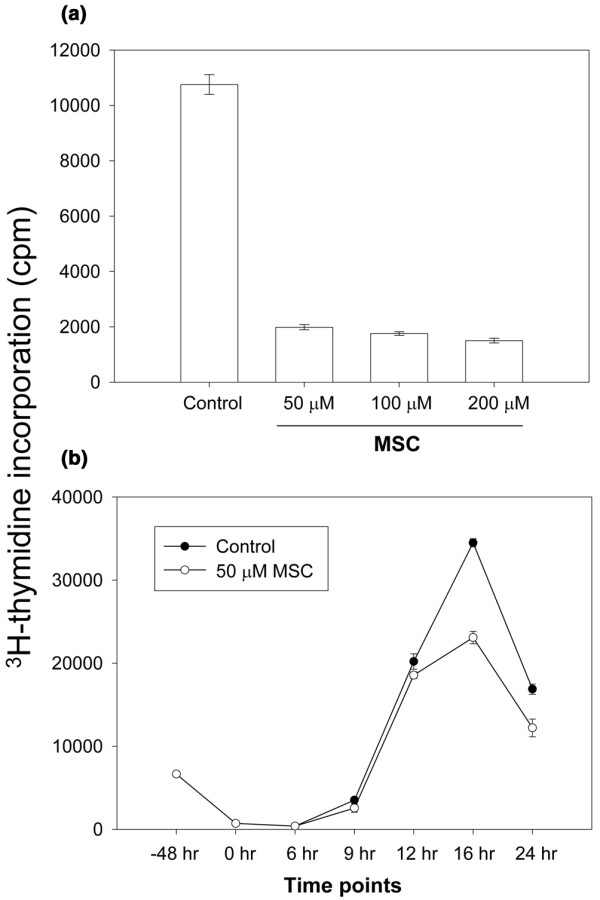
[3H]Thymidine incorporation into TM6 cells after Se-methylselenocysteine (MSC) treatment. (a) Asynchronous TM6 cells were grown for 24 hours and treated with various concentrations of MSC for 48 hours to determine the optimum dose for treating synchronized cells. (b) Synchronized TM6 cells were treated with 50 μM MSC at 6 hours and the DNA synthesis was measured by [3H]thymidine incorporation at the indicated time points as described in the Materials and methods section. Data are presented as means ± SEM for three observations at each given time point. MSC at 50 μM showed a greater ability to block DNA synthesis in asynchronous TM6 cells, mainly because of the extended time of treatment.